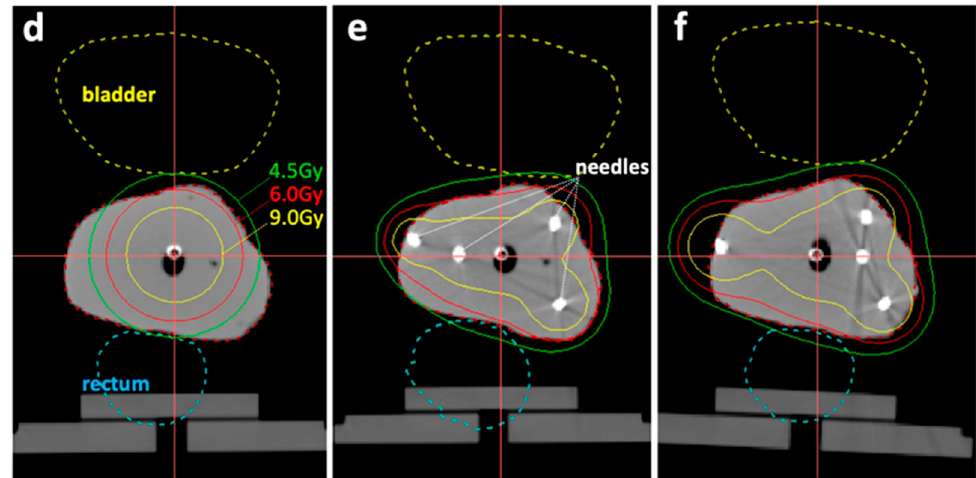
Figure 3. Representative dose-distributions for the treatment plans in the trial use of the IC/IS training simulator with: ( a ) Fletcher-Suit Asian Pacific applicator inserted by an expert; ( b ) Fletcher-Suit Asian Pacific applicator and interstitial needles inserted by the resident; ( c ) Fletcher-Suit Asian Pacific applicator and interstitial needles inserted by an expert; ( d ) Venezia applicator inserted by an expert; ( e ) Venezia applicator and interstitial needles inserted by the resident; or ( f ) Venezia applicator and interstitial needles inserted by expert.